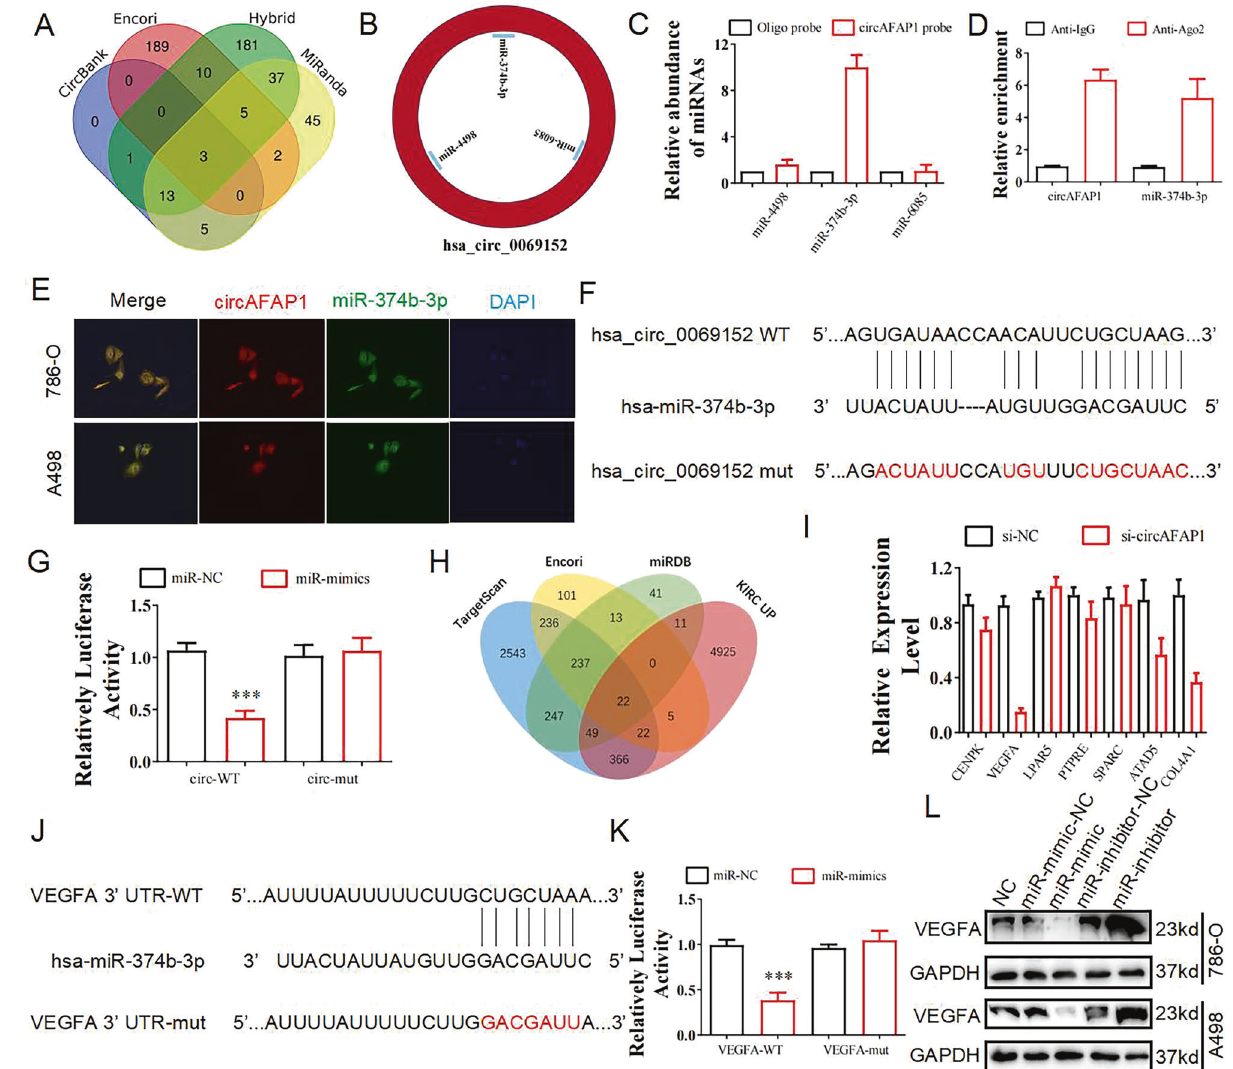
Fig. 3 circAFAP1 acts as a miR-374b-3p miRNA sponge in ccRCC cells and miR-374b-3p serves as an mRNA suppressor to regulate VEGFA expression. A Venn diagram predicted three potential targeted miRNAs binding with circAFAP1 from circbank, Encori, Hybrid, and MiRanda database. B miR-4498, miR-6085, miR-374b-3p were acquired from four before-mentioned software programs. C RNA pulldown assay supplied with qRT-PCR displayed circAFAP1 was bound with three miRNAs while the interaction between circAFAP1 with miR-374b-3p was strongest. Error bars indicate SD. D RIP experiments were performed in 786-O cells against IgG or Ago2. The results analyzed by qRT-PCR supported the correlation between circAFAP1 with miR-374b-3p. E FISH showed the subcellular co-localization between circAFAP1(red) and miR-374b-3p (green). DAPI (blue) was used to stain the nuclear. F Dual-luciferase reporter assays veri fi ed the exact binding site where circAFAP1 interaction with miR-374b-3p and mutated circAFAP1 sequence was shown as the last row. G The luciferase activity was determined 2 days after transfected with miRNA mimics normal control (miR-NC)/miR-374b-3p mimics (miR-mimics) in 786-O cells. ***represents p < 0.001. H Venn diagram presented potential targeted mRNAs regulated by miR-374b-3p from Targetscan, miRDB, Encori, and TCGA database. I qRT-PCR showed seven mRNAs were differentially expressed in 786-O cells with or without transfecting si-circAFAP1 while the most signi fi cant difference between these two kinds of cells was observed in VEGFA. J Dual-luciferase reporter assays veri fi ed the exact binding site where VFGFA mRNA interaction with miR-374b-3p and mutated VFGFA mRNA sequence was shown in the last row. K The luciferase activities were determined 2 days after transfecting miRNA mimics negative control (miR-NC)/miR-374b-3p mimics (miR-mimics) in 786-O cells. ***represents p < 0.001. L Western blot displayed the VEGFA levels among 786-O and A498 cells, both of which were transfected with miR-NC, miR-mimic, miR-inhibitor-NC, or miR-inhibitor respectively. GAPDH was used as the reference